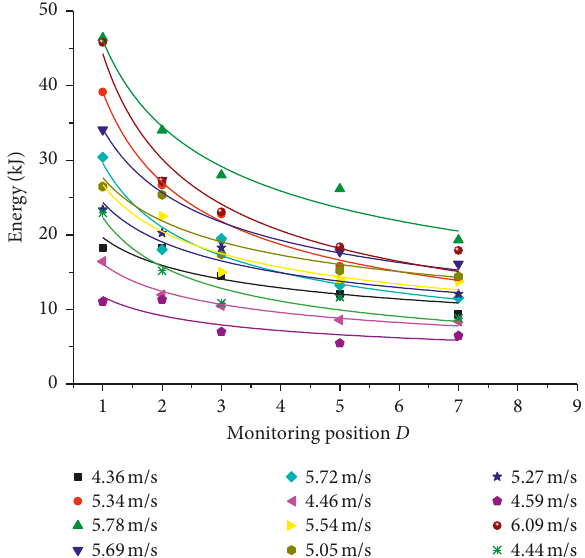
Figure 8: Energy attenuation law under different impact